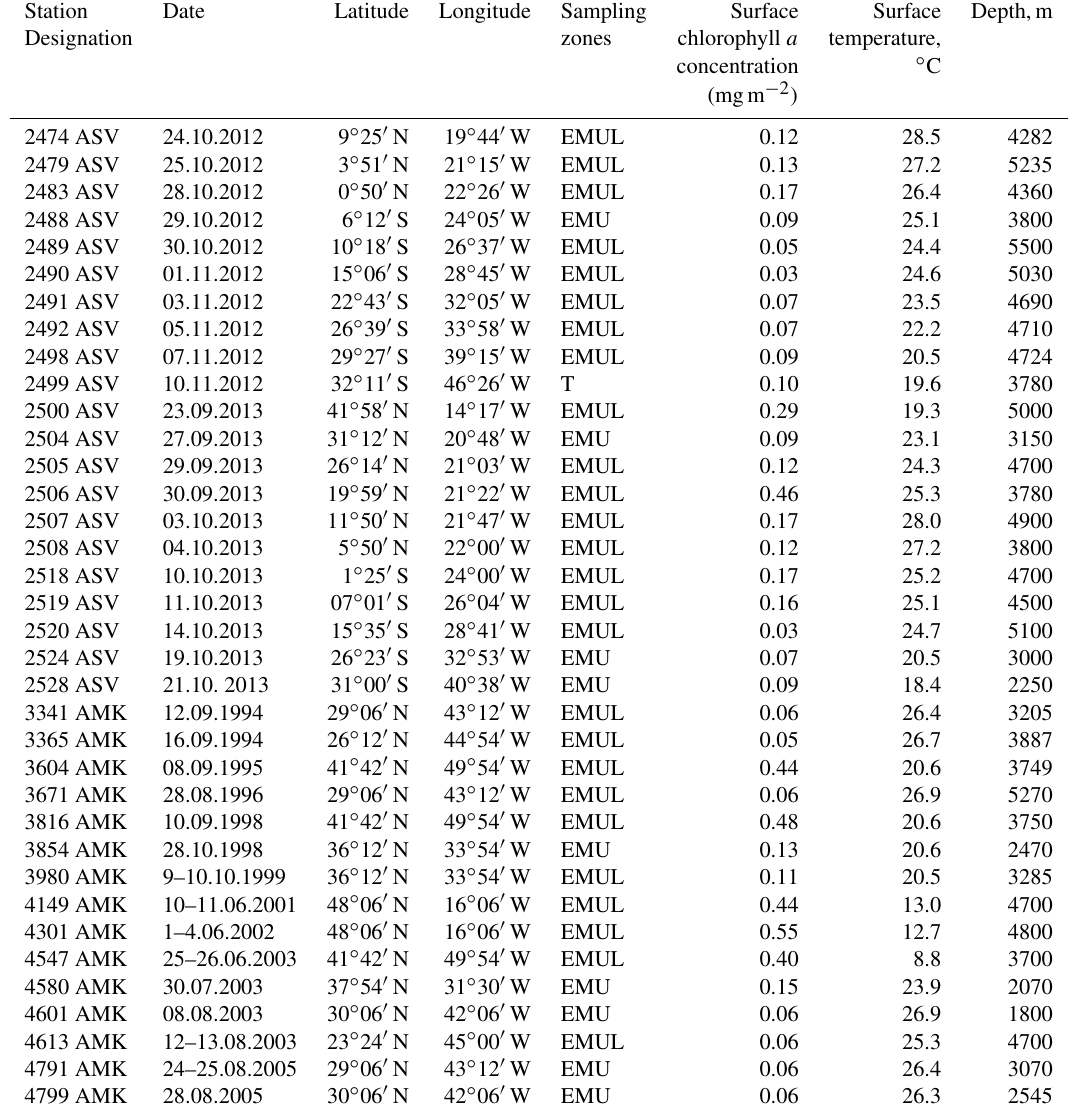
Table 1. List of stations and cruises of R/V Akademik Sergey Vavilov (ASV) and R/V Akademik Mstislav Keldysh (AMK). Sampling zones: E – epipelagic; M – main thermocline; U – upper bathypelagic; L – lower bathypelagic; T – total haul (0–3000m; net was not